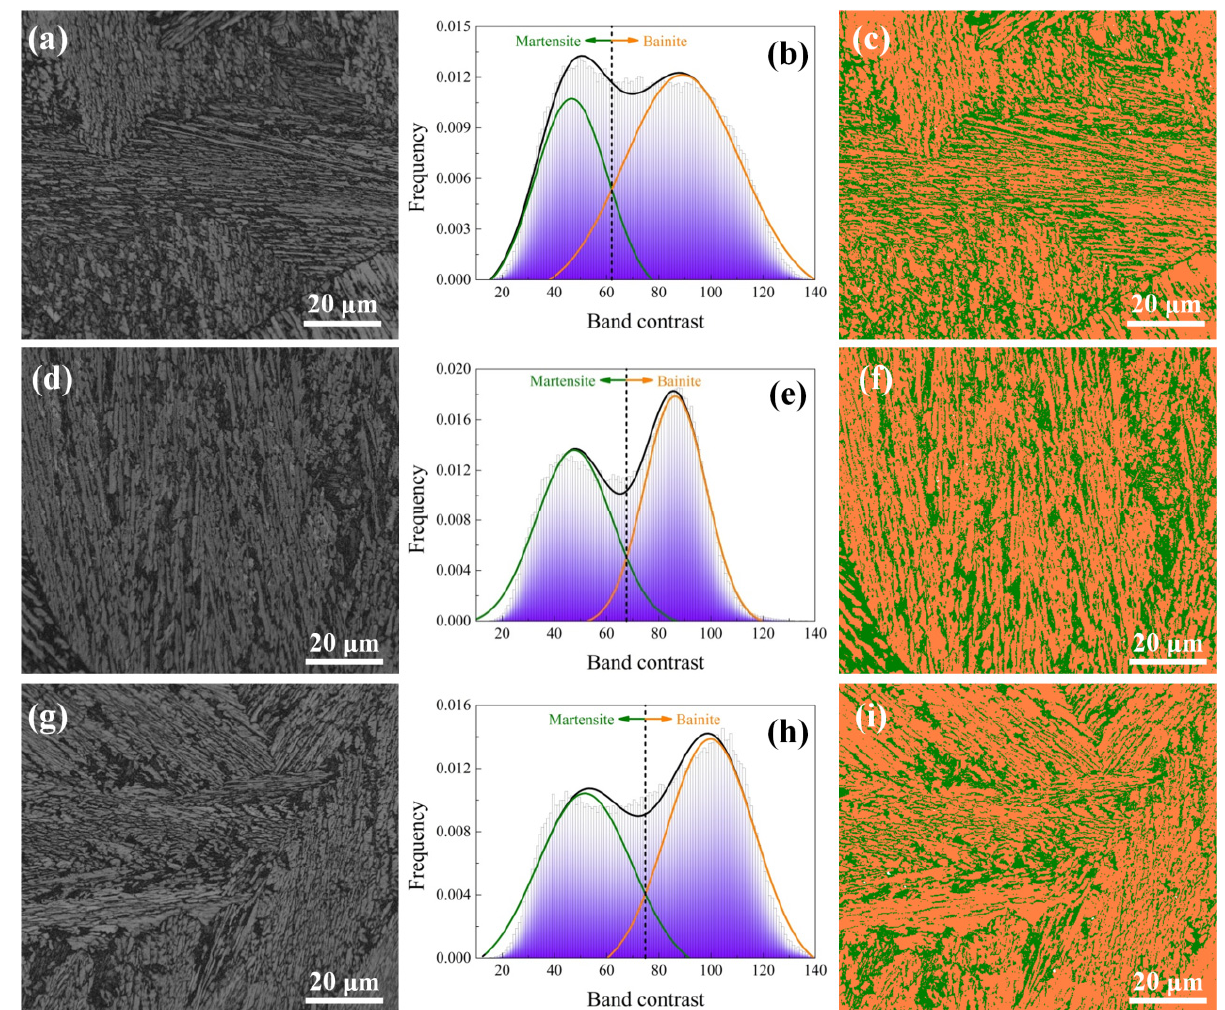
Figure 4. ( a , d , g ) BC maps, ( b , e , f ) the distribution of BC values and Gaussian fit and ( c , f , i ) BC maps based on the Gaussian fit of ( a – c ) IT698, ( b – f ) IT673 and ( g – i ) IT623 (Martensite and bainite in ( c , f , i ) are colored in olive and orange, respectively.).